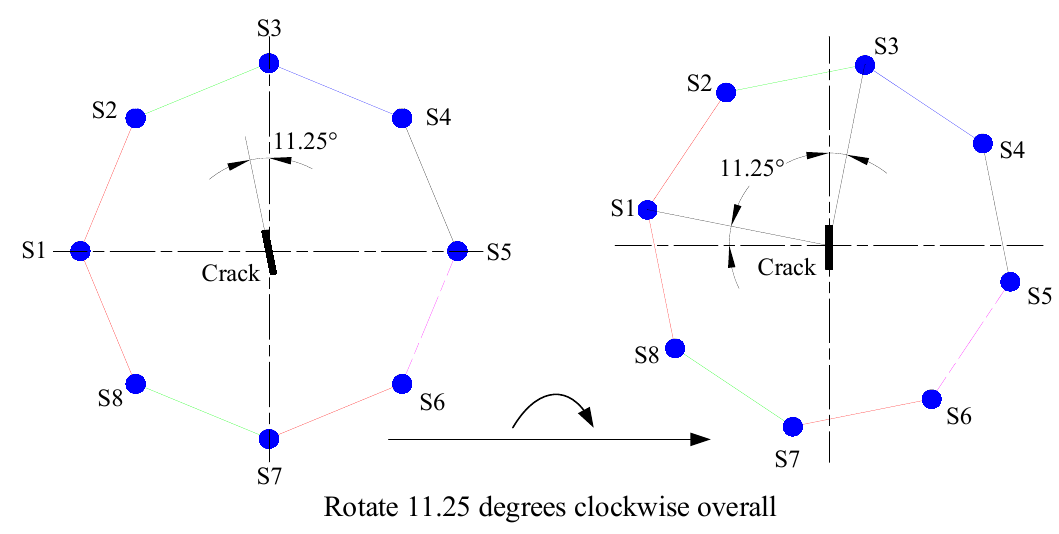
Figure 5. Schematic diagram of the oblique crack conversion process.